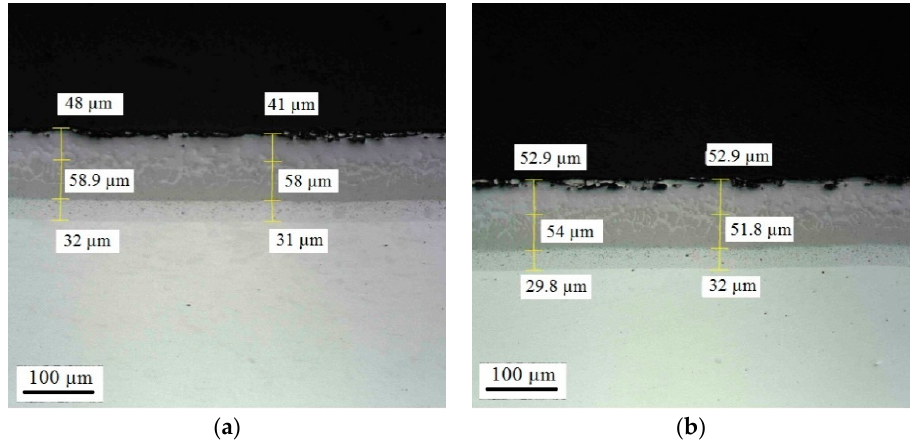
Figure A17. Microscopic images of the cross-section of CS-Cr ( a ) before and ( b ) after the high-temperature corrosive attack after 168 h.